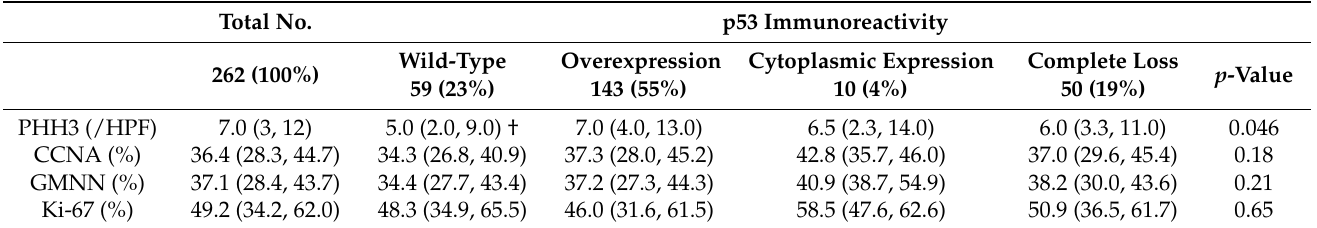
Table 3. Association between p53 immunoreactivity and cellular proliferation marker expressions.